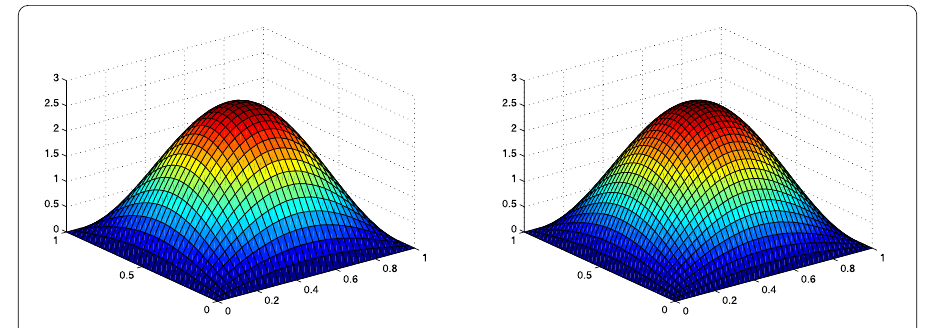
Figure 3 The surfaces of u h and u at t = 1 s when h = 1